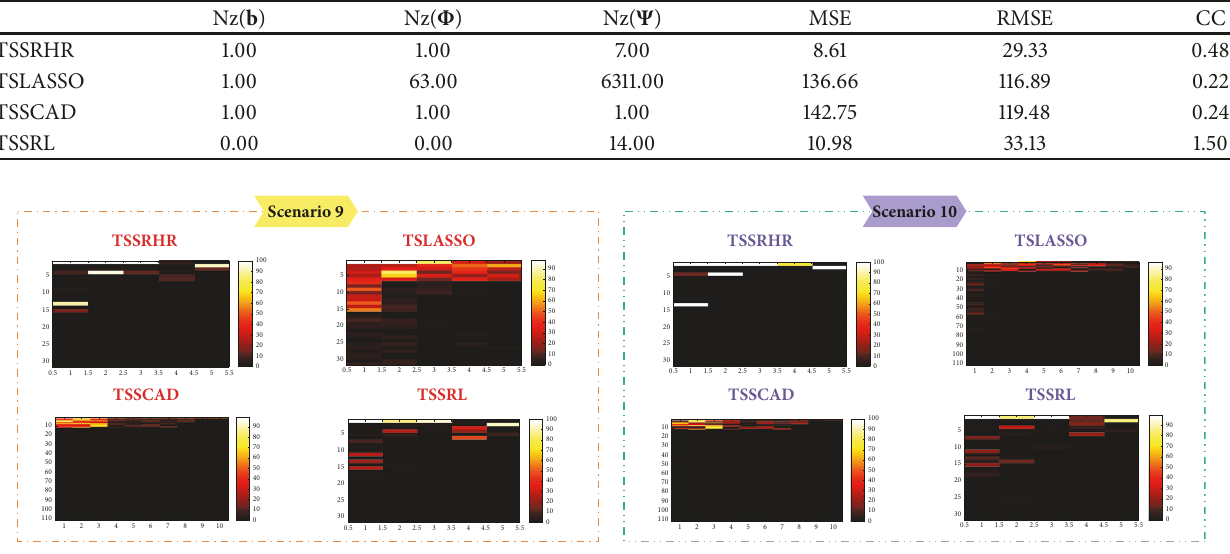
Figure 4: Sparsity pattern of compared forecasting methods in Scenarios